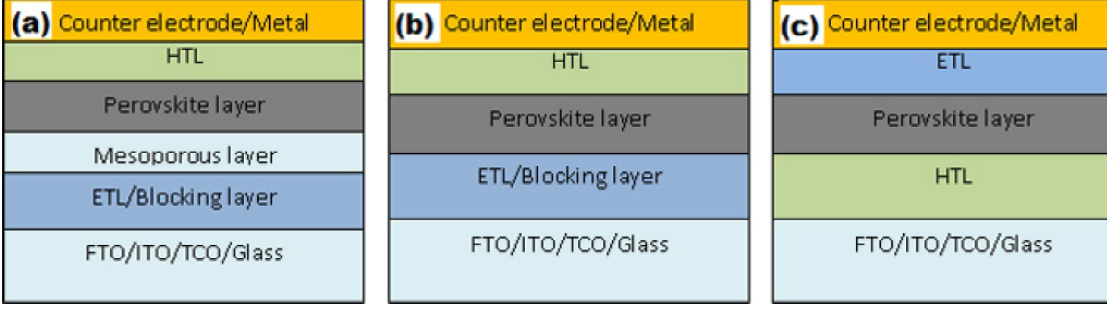
Fig. 7. (a) Mesoporous versus (b) planer n-i-p and (c) planer p-i-n structure of